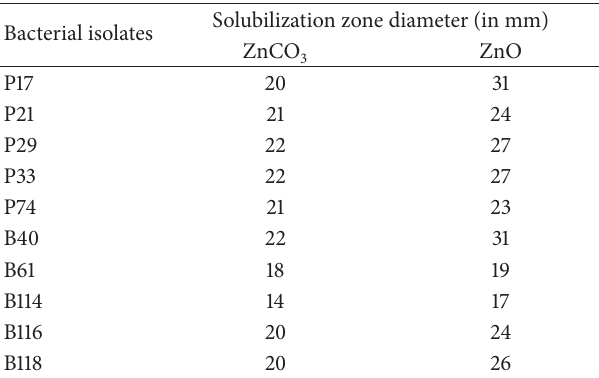
Table 1: Zinc solubilizing ability of Pseudomonas and Bacillus isolates with insoluble zinc substrates on solid